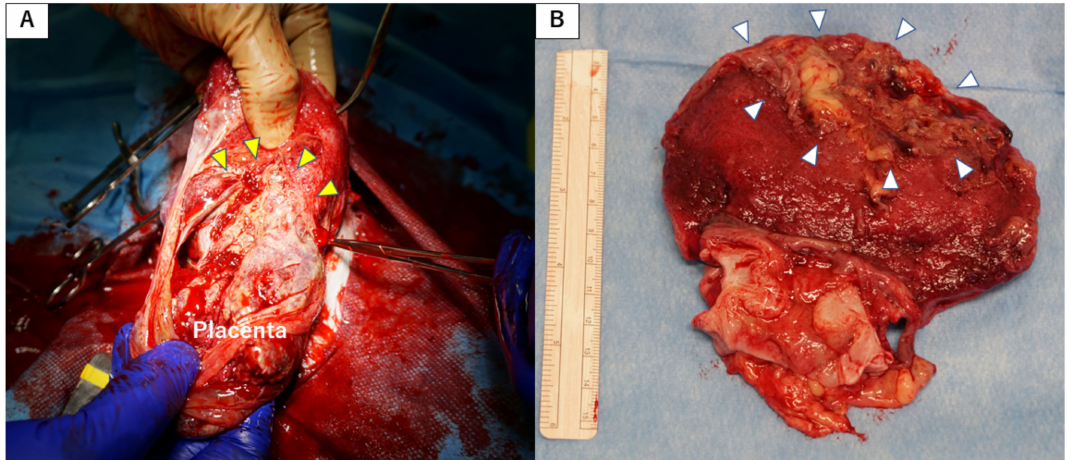
Figure 11. First pregnancy and delivery after allogeneic uterus transplantation in a cynomolgus macaque. ( A ) Fetal heartbeat as per Doppler ultrasonography. Fetal viability was confirmed by transabdominal ultrasonography in case 2, with a crown-rump length of 11.7 mm and fetal cardiac activity. ( B ) Intraoperative findings of the cesarean section. Transverse incision of the lower part of uterus was performed.